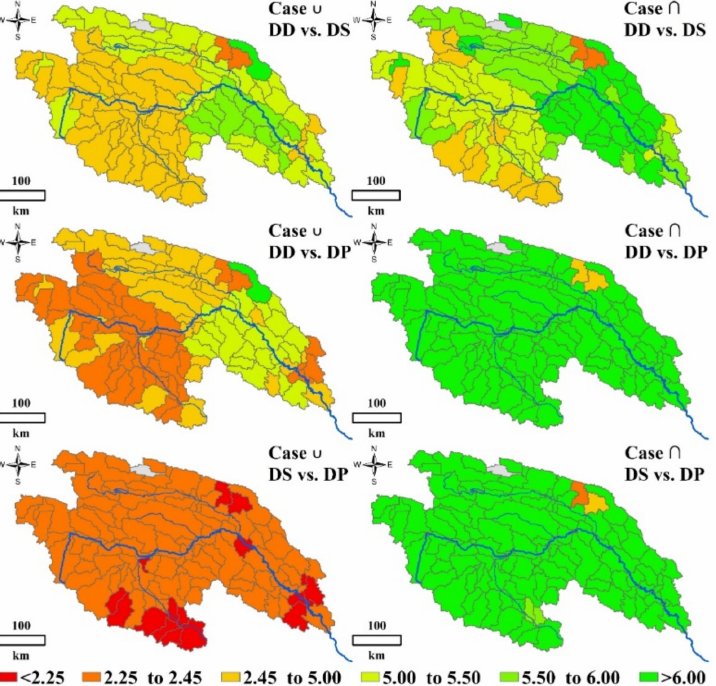
Figure 17. Spatial distribution of bivariate return periods of DD vs. DS , DD vs. DP and DS vs. DP in Case ∪ and Case ∩ in the